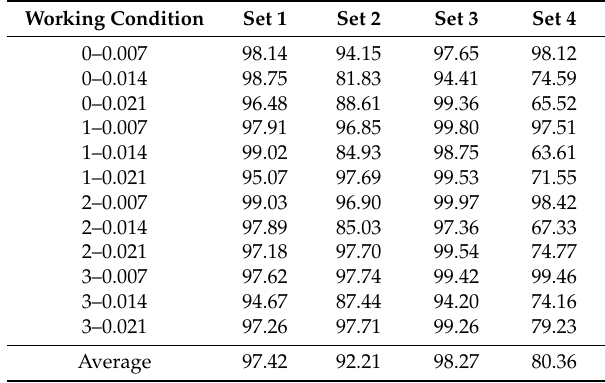
Table 4. Variances of diagnostic accuracy of all independent experiments corresponding to 12 different working conditions respectively in 1st – 4th experiment sets.